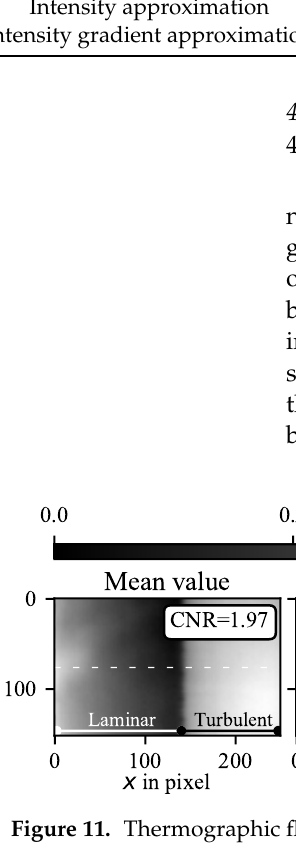
Figure 11. Thermographic flow visualization of the DU96W180 airfoil in cross-flow with a Reynolds number of 3 × 10 6 . Temporal mean value and temporal standard deviation as well as principal components (PC) no. 1–3 from the PCA of the image series. Systematic inhomogeneities in the flow regimes are reduced in the PC, while a contrast between the laminar and turbulent flow regime is maximized in the mean value with CNR =